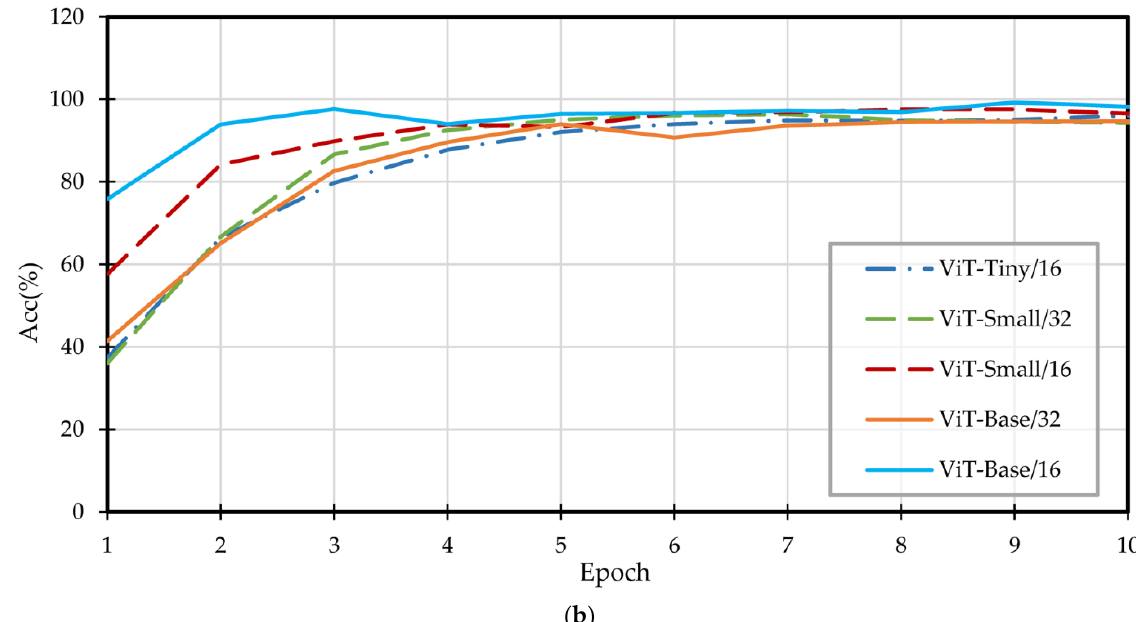
Figure 7. Training curves of ViT. ( a ) Loss curves of the training set and validation set; ( b ) training curves of the validation set.